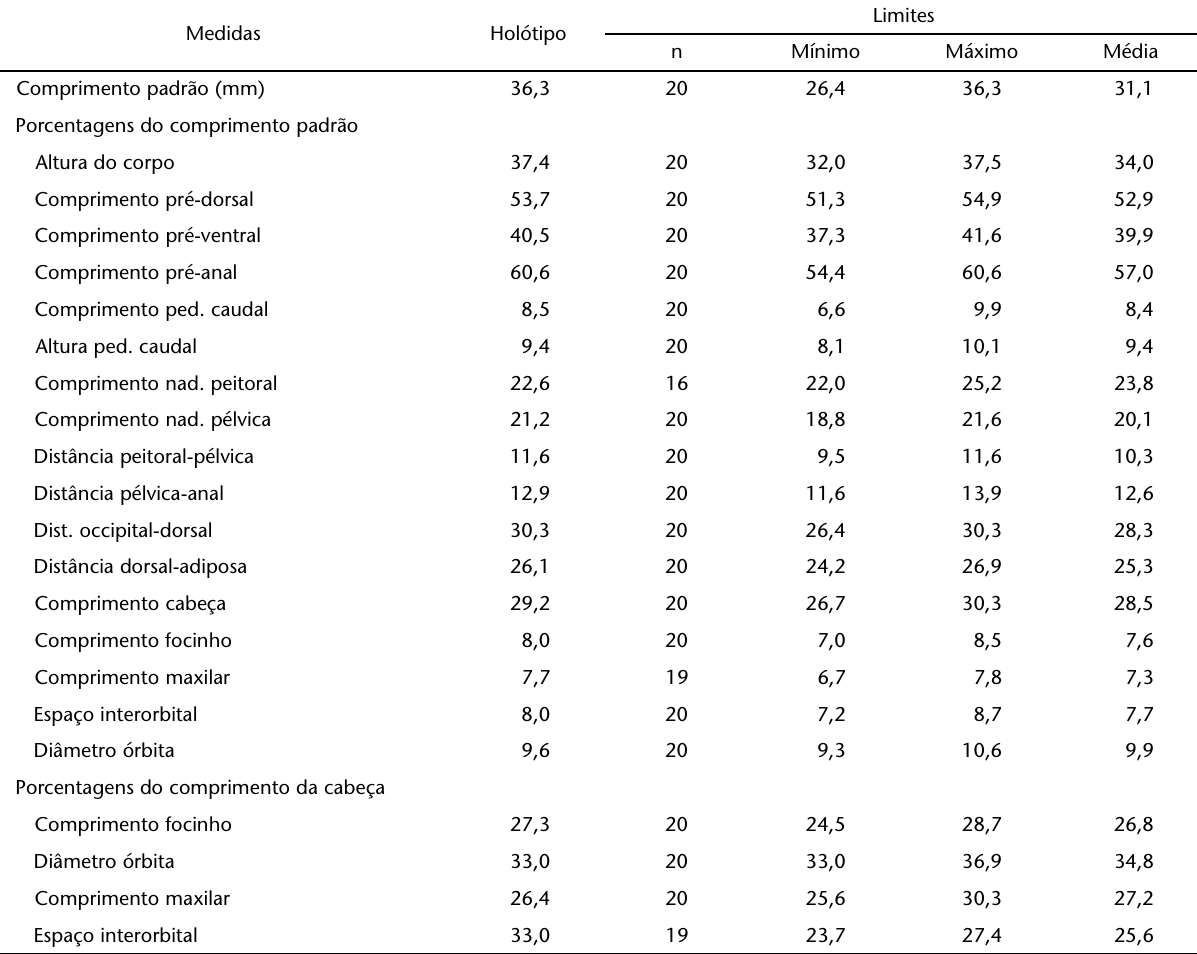
Tabela IV. Medidas de P. ojitatus sp. nov. , holótipo MZUSP 30551. (n) Número de exemplares, incluindo o holótipo.